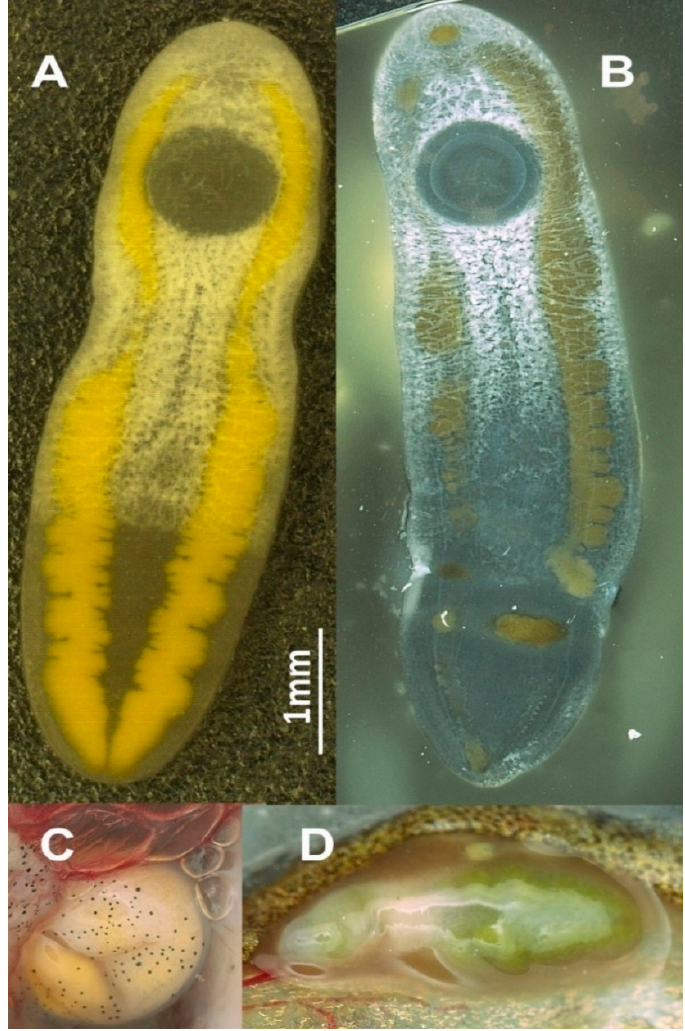
Figure 4. Color variation of the gut content in fully grown metacercaria C. chabaudii (body length 7– 8 mm). ( A , C ) Specimen with yellow content of intestines collected from H. kivuensis . ( B , D ) Brownish green counterpart collected from H. viridiflavus . Excysted ( A , B ) and encysted specimens ( C , D ) are shown in life. Note that the specimen shown in ( B ) was illuminated by transmitted light in contrast to the other specimens, which were illuminated by incident light.